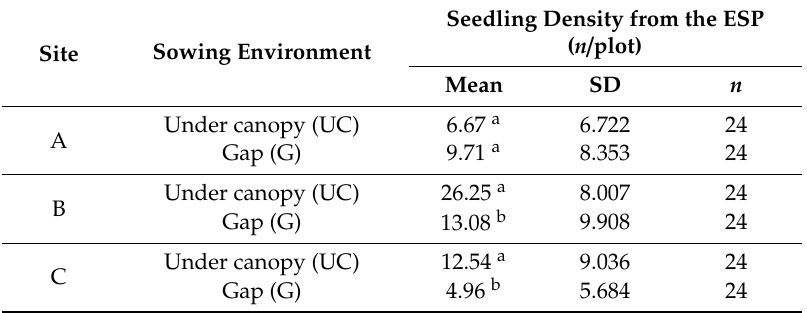
Table 8. Mean density of P. brutia seedlings which survived from the ESP (December 2009) in the plots which were established in the under canopy and in the gap sowing environment (averaged over the two levels of the factor ‘water supplementation’) in each of the three sites (‘sowing environment’ main effect).